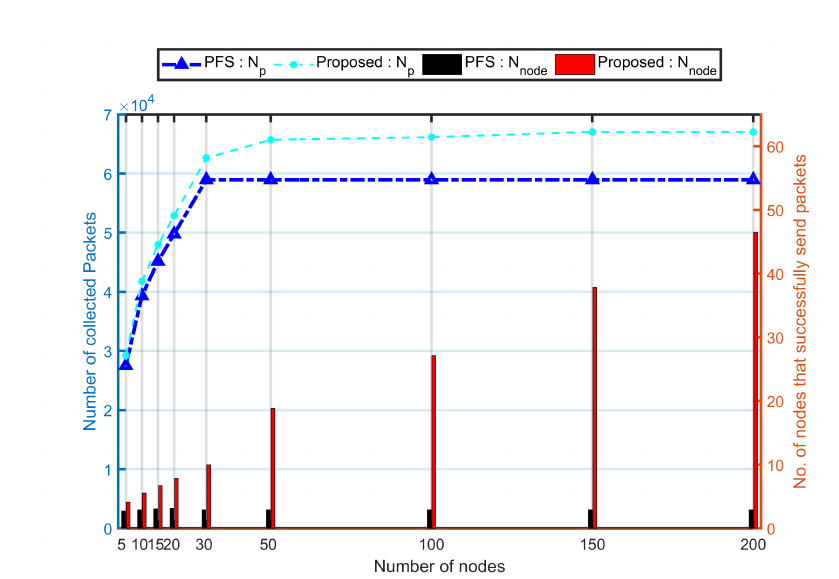
Figure 9. Evaluation of proposed algorithm (the combination of proposed Balance and PCdFS algorithms) on network size.